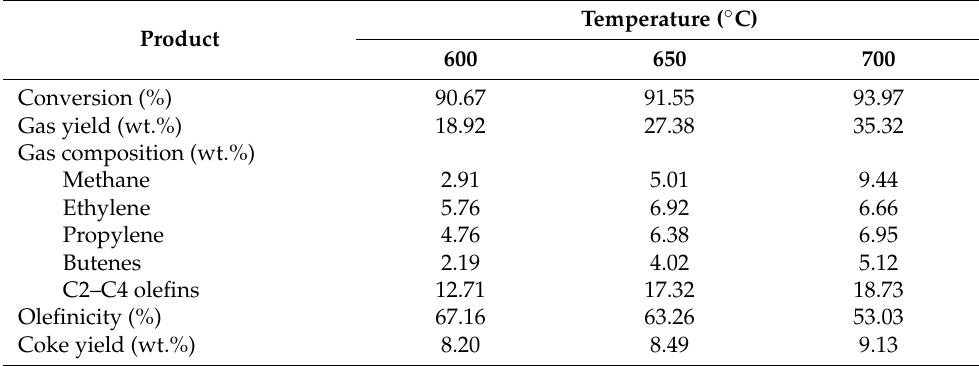
Table 3. Conversion and composition of thermal cracking products of VR